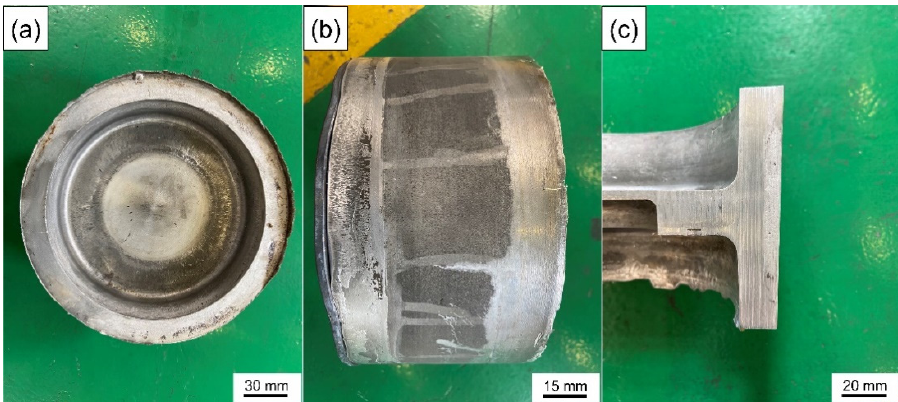
Figure 14. The actual image of the brake drum: ( a ) top view, ( b ) side view (The iron gasket with a certain thickness is to facilitate ejection and demolding) and ( c ) section view.